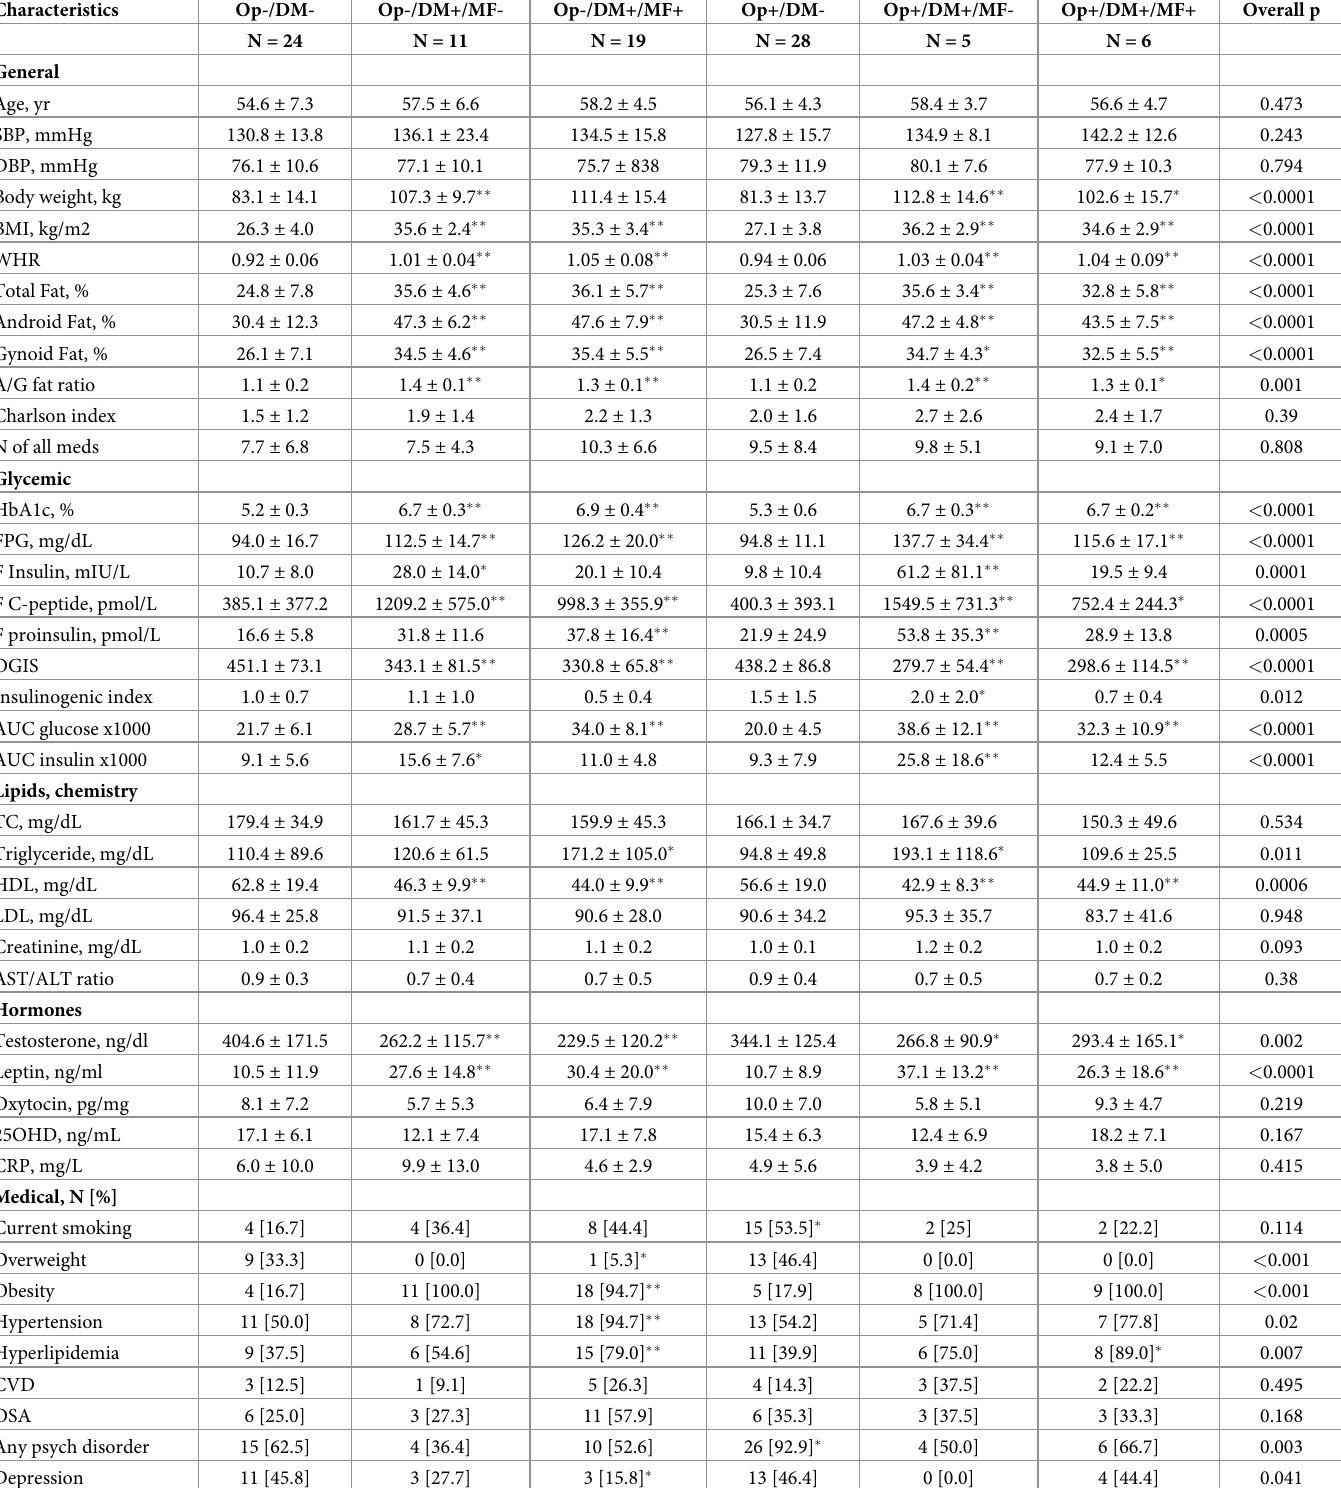
Table 1. Subject